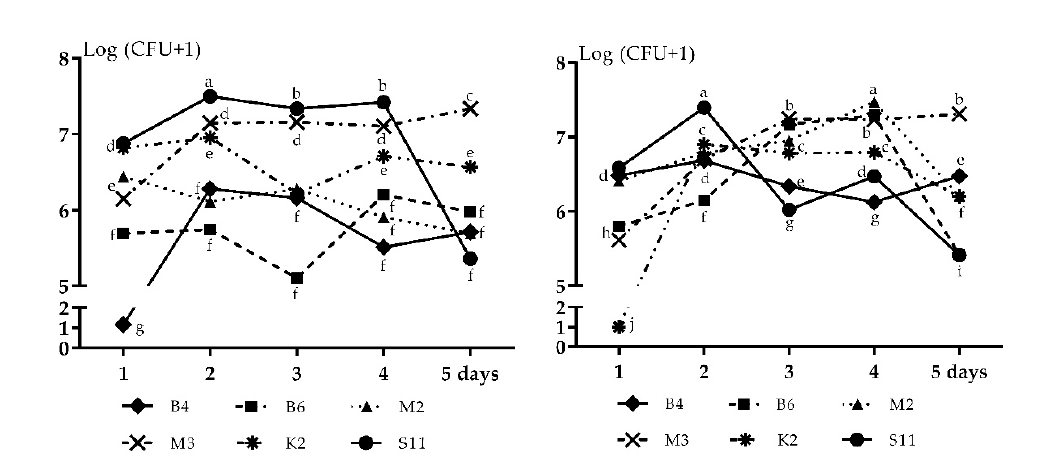
Figure 6. Survival of bacteria on the leaves of wheat cvs. Tonacja (left) and Bogatka (right). CFU—colony-forming unit. Values that do not differ significantly between columns based on the results of the SNK test ( p < 0.01) are marked with identical letters.